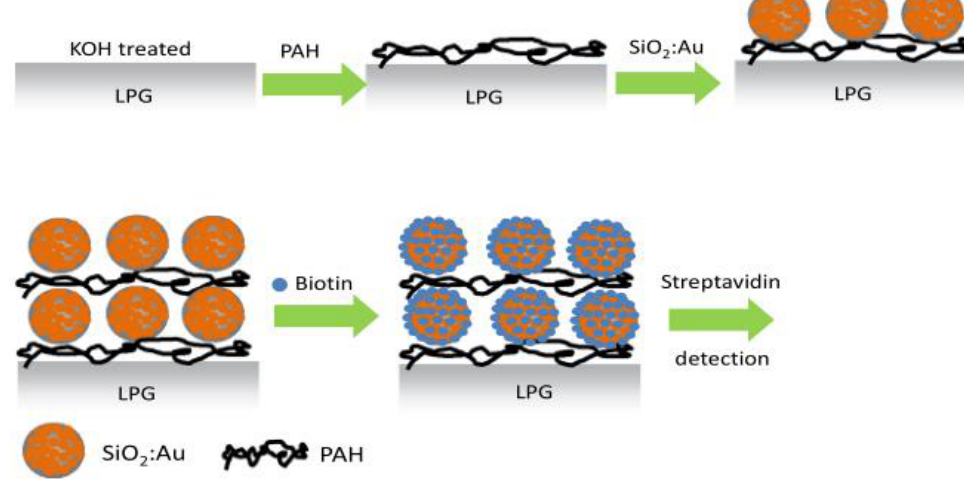
Figure 4. ( a ) PMC for LP 0,12 cladding mode as a function of the fiber diameter with a grating period of 165 mm (solid black line corresponds to the non-etched fiber, whereas solid dark gray line corre- sponds to the closest curve to the DTP condition). ( b ) Simulated spectra of LPFG with grating period of 165 µm for decreasing thickness of the fiber diameter d clad from 125 µm up to 123.4 µm, detailing the evolution of the dual resonance bands up to DTP (solid dark grey line). Reprinted with permis- sion from [42]. Copyright © 2014 Elsevier B.V.